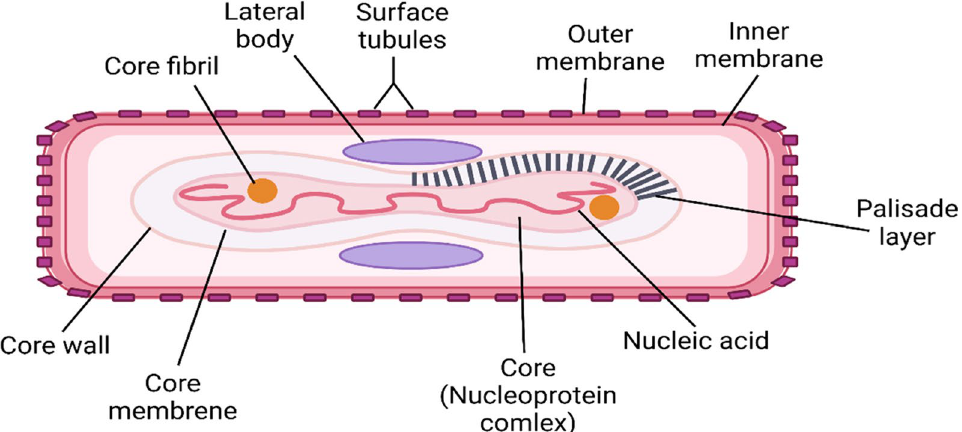
Fig. 5 Structure of monkeypox virus: Human MPX is an enveloped dsDNA MPXV which has 250 nm width and 170–250 kb in size of DNA genome. MPXV consist of surface tubules, outer envelope of extracellular virion, lateral bodies, plasid layer, core fibrils, and outer membrane of intracellular and extracellular